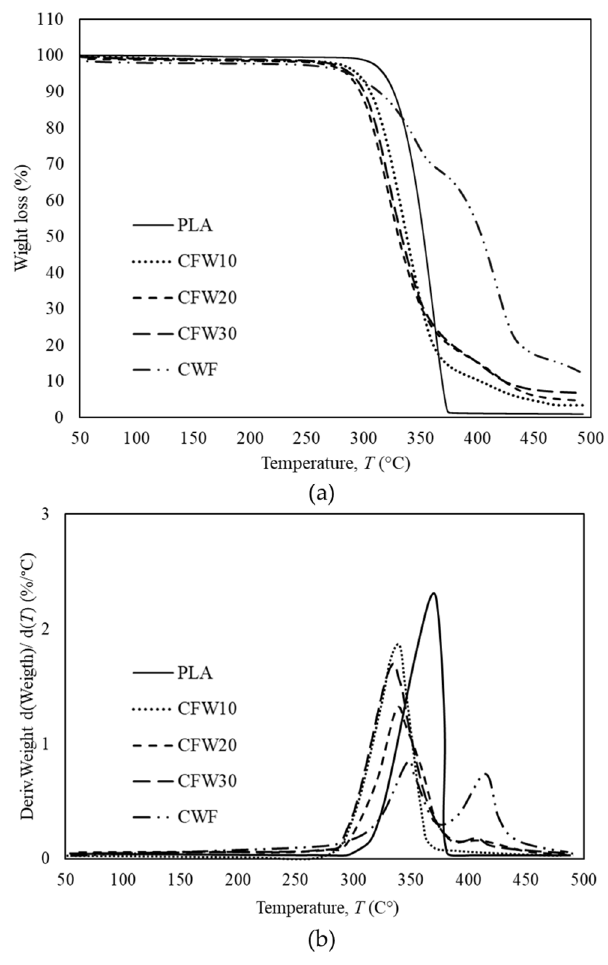
Figure 9. ( a ) TGA and ( b ) DTG thermograms of the PLA/CFW .